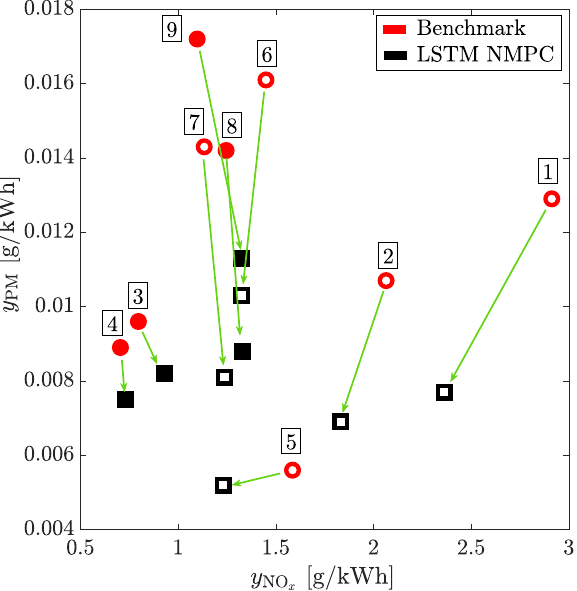
Figure 14. Experimental results: PM vs. NOx trade-off improvement—filled shapes ( ), NO x is slightly increased (case 3,4, 8, and 9), while remaining cases ( ), both PM and NO x are